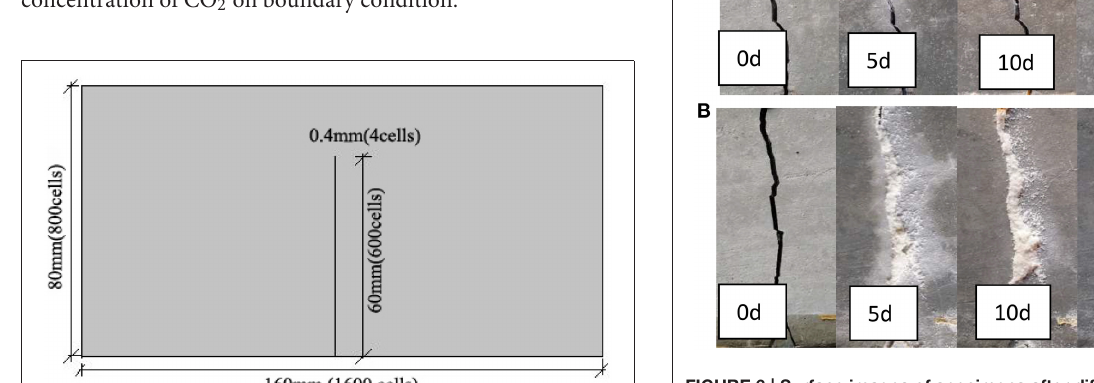
FIGURE 6 | Surface images of specimens after different healing time. (A) G1, Specimens without self-healing agent; (B) G4, specimens with self-healing